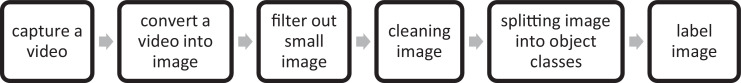
Process flow diagram in developing a dataset.